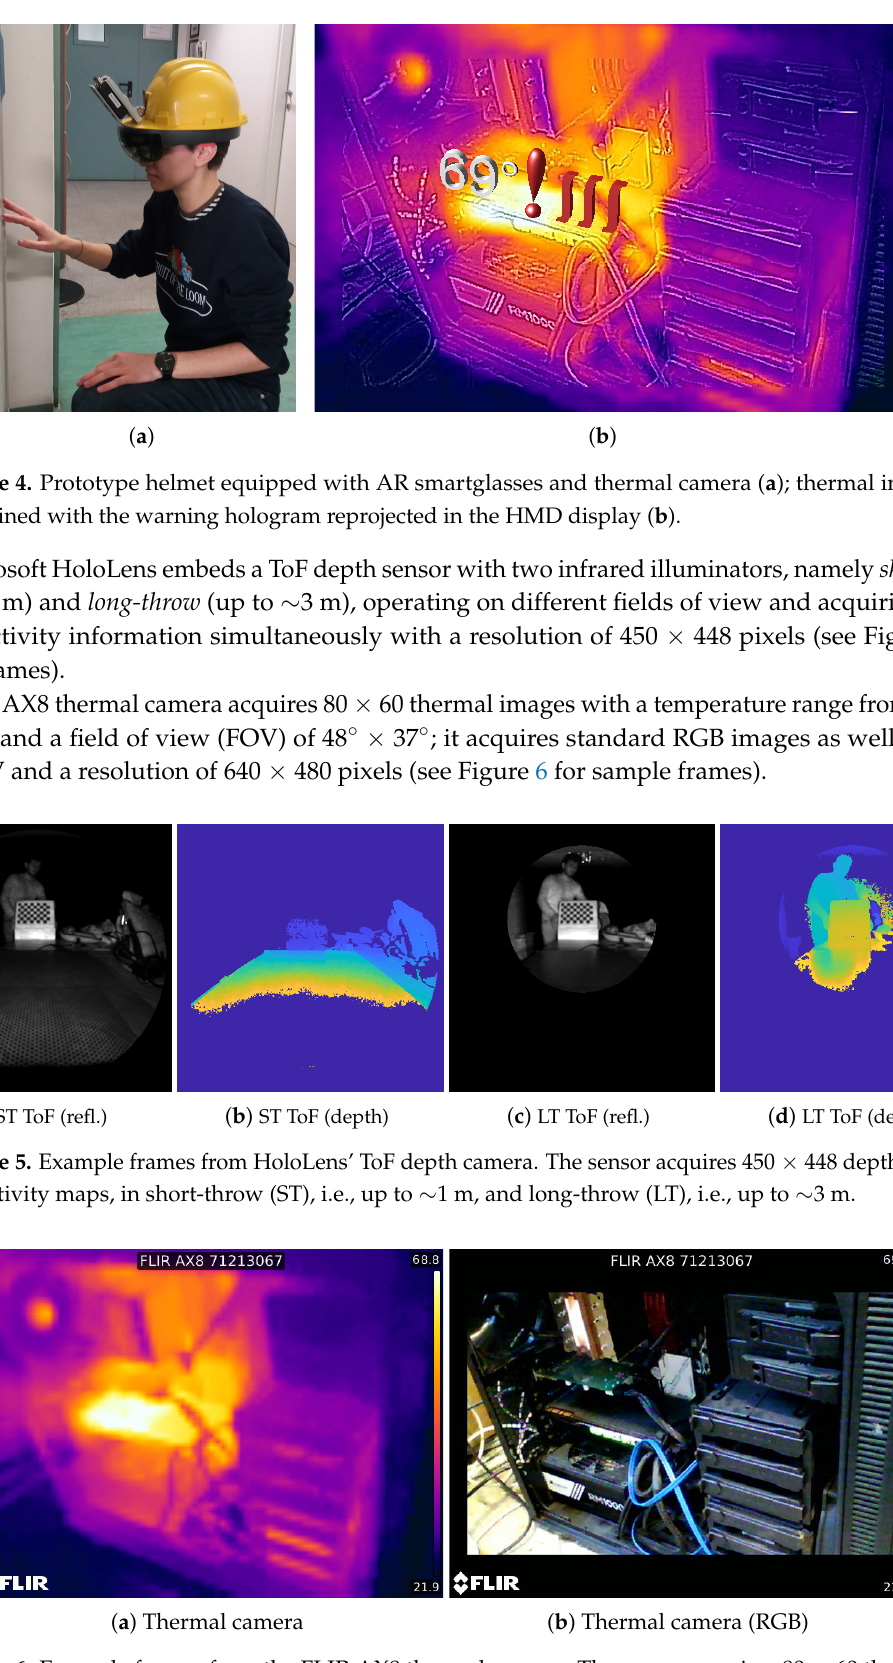
Figure 6. Example frames from the FLIR AX8 thermal camera. The sensor acquires 80 × 60 thermal maps and 640 × 480 RGB